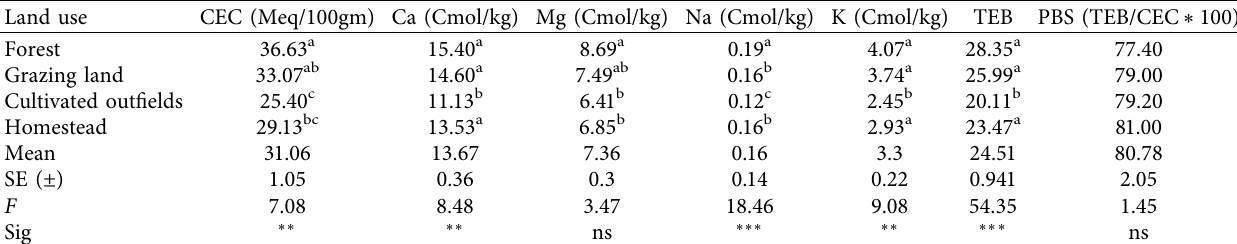
Table 5: Mean values of CEC and exchangeable basic cations as affected by land